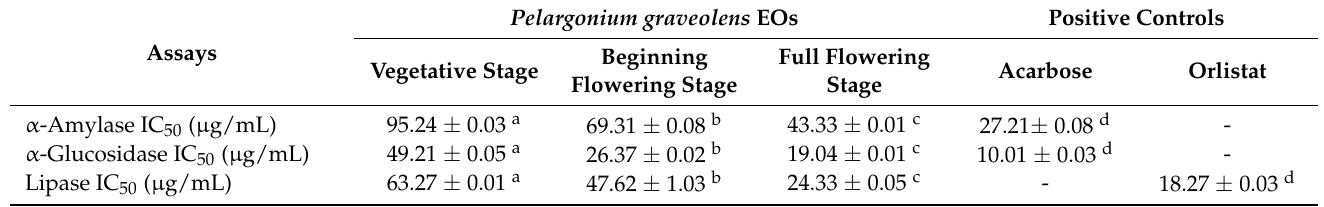
Table 5. The antidiabetic activity of PGEOs (IC 50 in µ g/mL) at three developmental stages. Results are presented as means ± SD (standard deviations) for triplicate